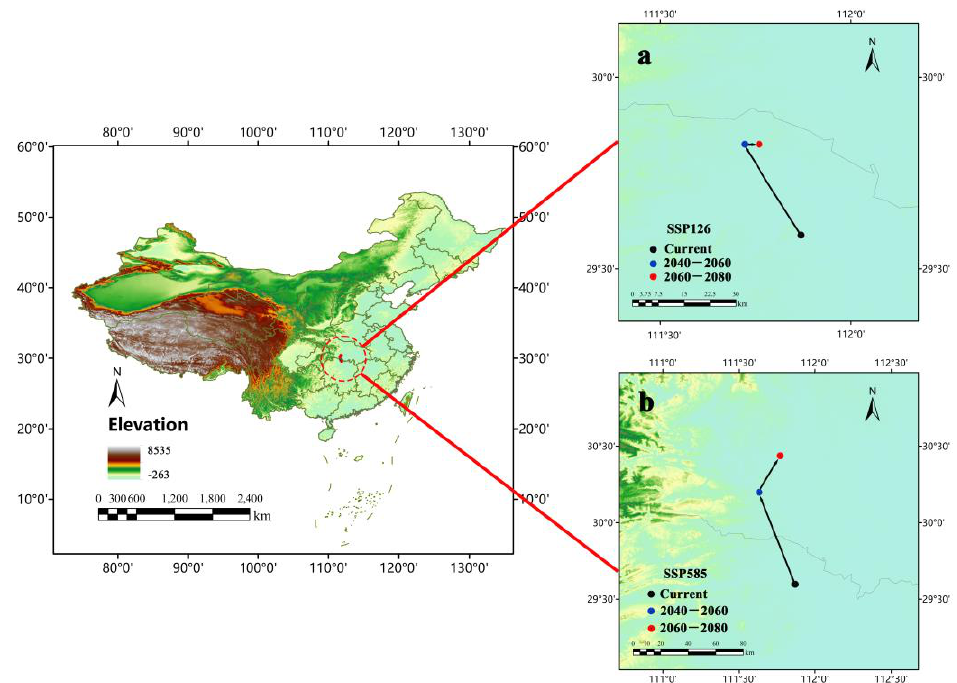
and 15,644.75 km 2 (SSP585). Furthermore, areas indicating areas of momentary fluctuations among